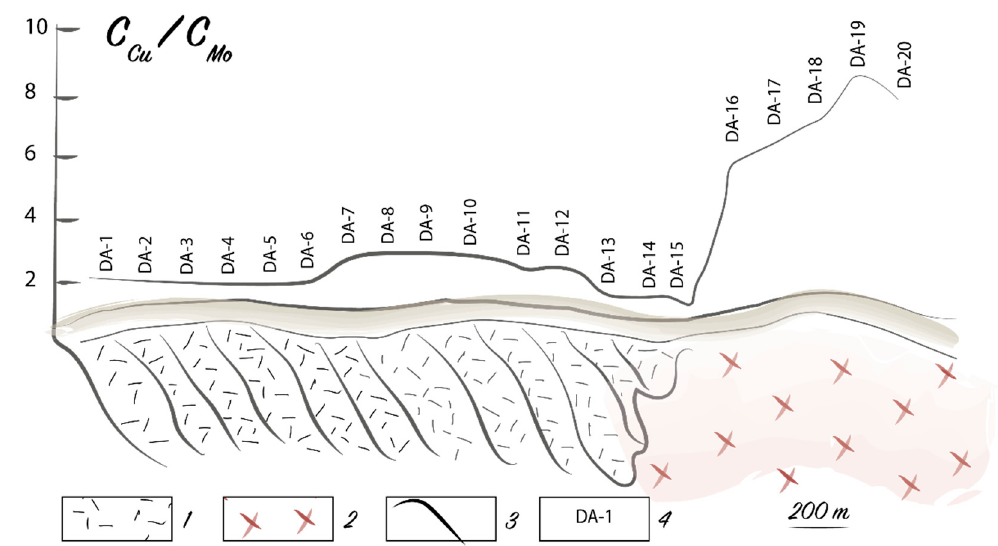
Figure 8. Proportion of Cu and Mo content in the ash of meadowsweet ( Spiraea hypericifolia L.) over the changing bedrocks in the Dzungarian Alatau. Symbols: 1—effusive and tufogenic rocks; 2—granites; 3—proportion curve; 4—sample numbers.